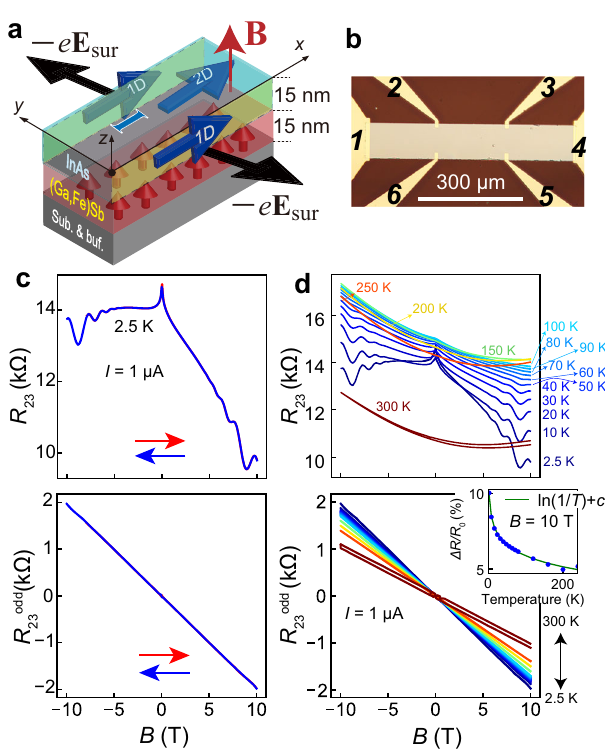
Fig. 1 | Magnetoresistances (MRs) of InAs/(Ga,Fe)Sb bilayer heterostructures. a Schematic illustration of the InAs/(Ga,Fe)Sb heterostructure with 1D transport channelsatthesideedges.Weappliedanelectriccurrent I paralleltothe x -axisand an external magnetic fi eld B parallel to the z -axis. Because (Ga,Fe)Sb is insulating, electron carriers fl ow only in the InAs QW layer, both in the 2D channel and the 1D channels at the edges. The triangular potentials at the side surfaces create static electric fi elds E sur parallel to the y -axis at the side edges of the InAs QW. b Optical microscopy top view image of the device. The terminals are labeled “ 1 ”–“ 6 ” , as shown in the image. c (Upper panel) MR of the InAs/(Ga,Fe)Sb heterostructure of sample A, measured with a DC current of 1 μ A and an external magnetic fi eld B appliedparallelto z at2.5K.Theblueandredarrowsindicatethesweepdirection of B . (Bottom panel) Extracted odd components of the upper panel data ( R 23 odd = [ R 23 ( B ) − R 23 ( − B )]/2). d Temperature dependences of R 23 and R 23 odd of sample A at 2.5 – 300Kwith I =1 μ A.Althoughtheeven-functionMRandtheShubnikov – deHaas oscillation disappear at high temperatures, the OMR component remains up to 300K. The inset of the lower panel shows the temperature dependence of Δ R / R 0 , where Δ R = R 23 odd (10T)and R 0 = R 23 (0T)(bluecircles).Thegreencurveisthe fi tting result obtained using the logarithmic function ln(1/ T )+ c ( T temperature, c temperature-independent